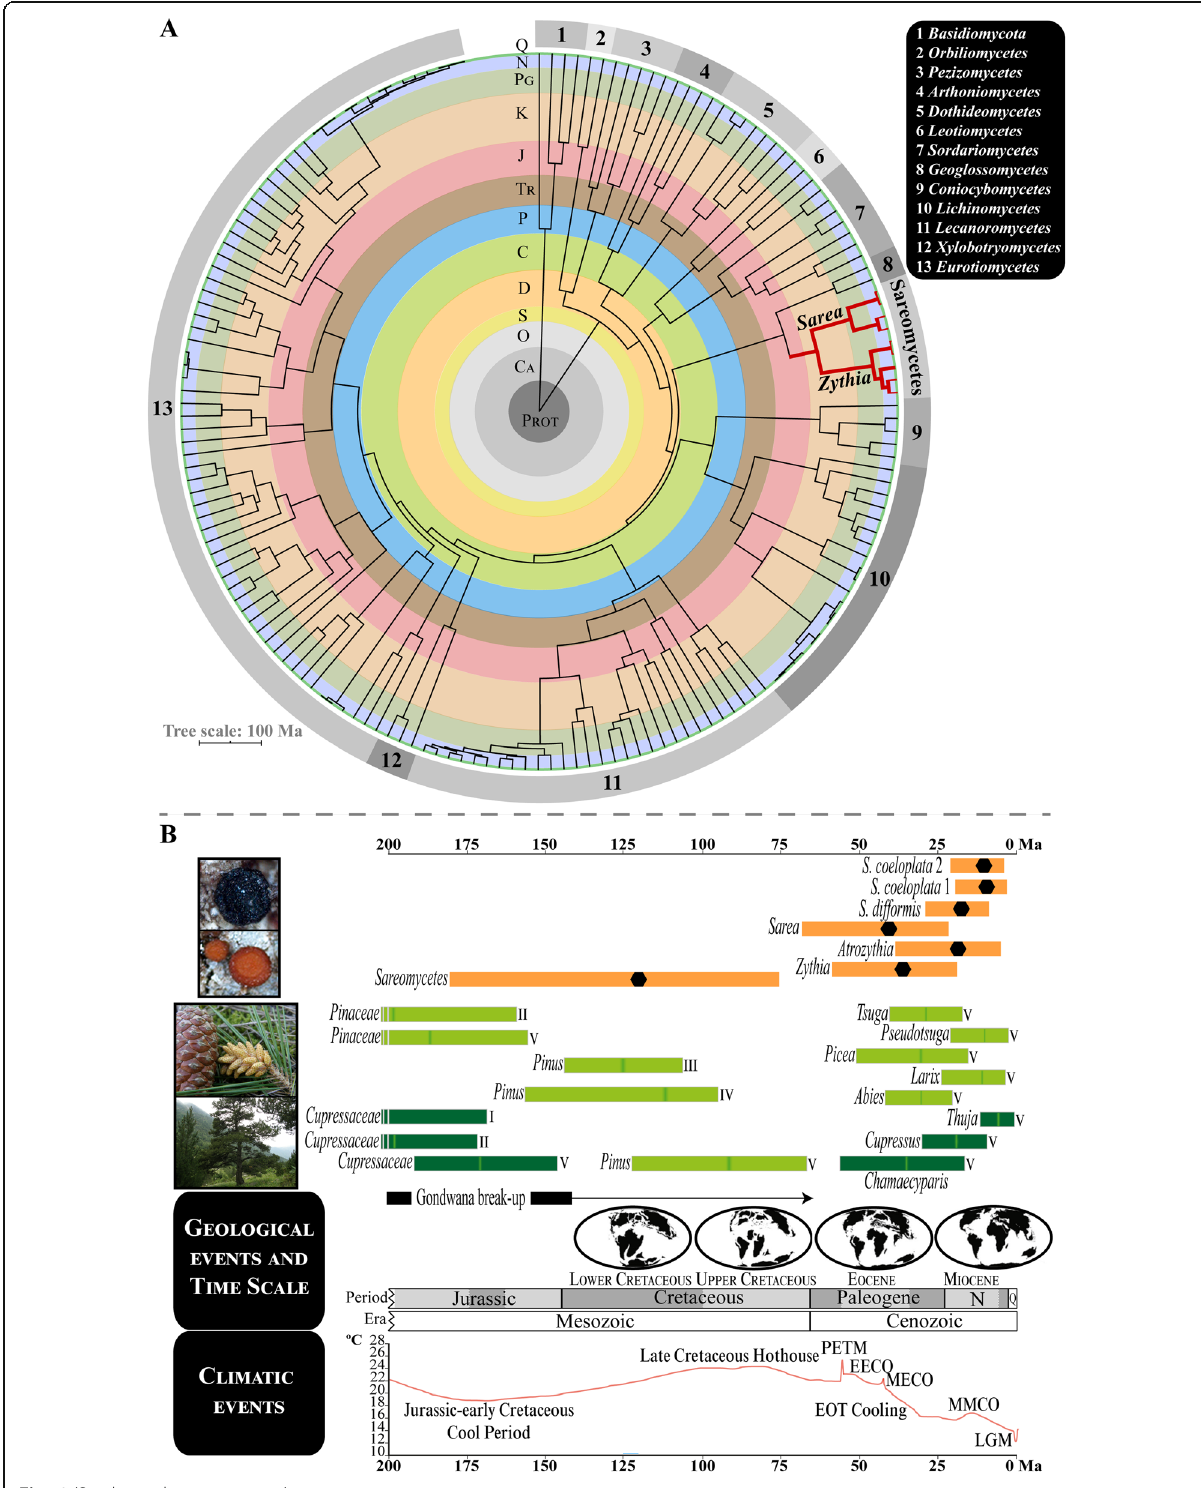
Fig. 6 (See legend on next